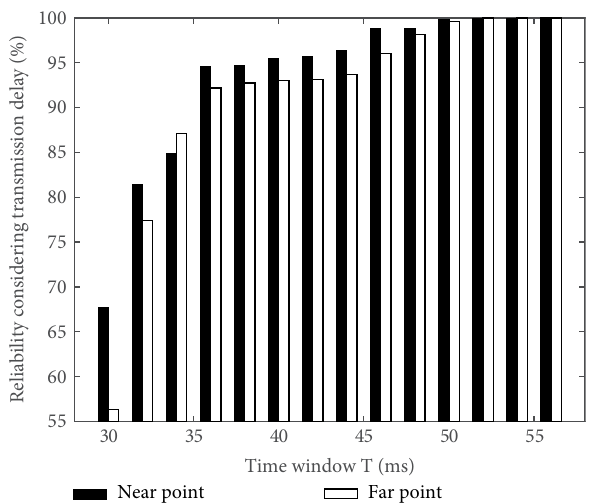
Figure 10: Reliability considering transmission delay.